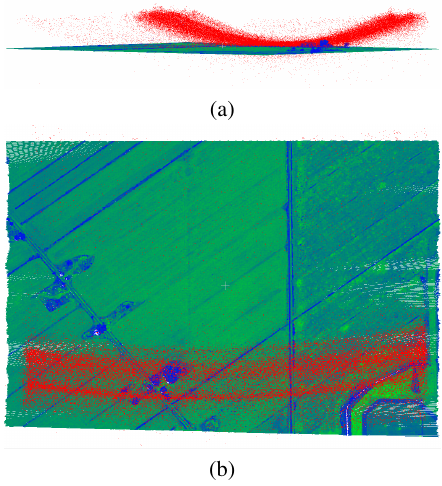
Figure 1: 3D point cloud from Galaxy T1000 (a) Sideview, (b) Top view; red points represent